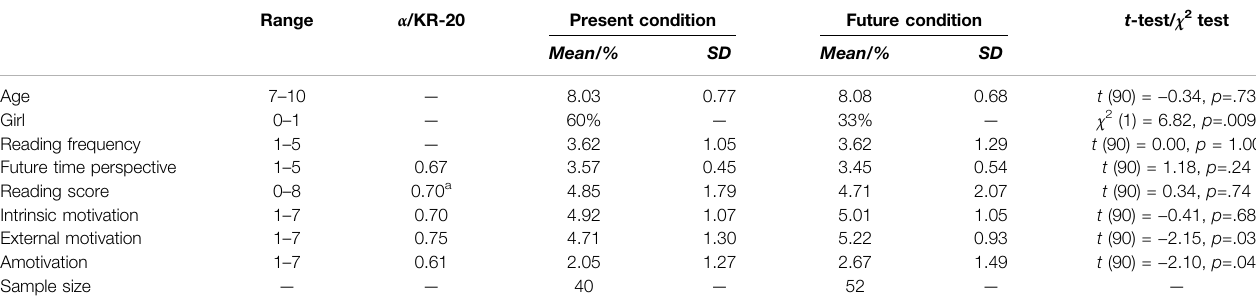
TABLE 1 | Sample characteristics by experimental conditions (N (cid:1) 92).